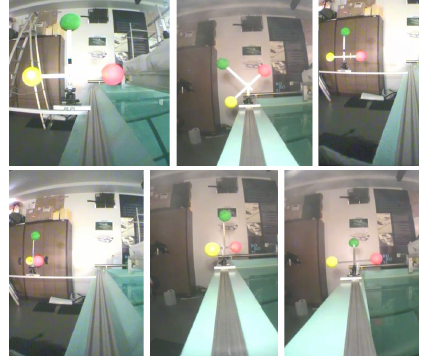
Figure 20. Pose estimator: experimental validation.